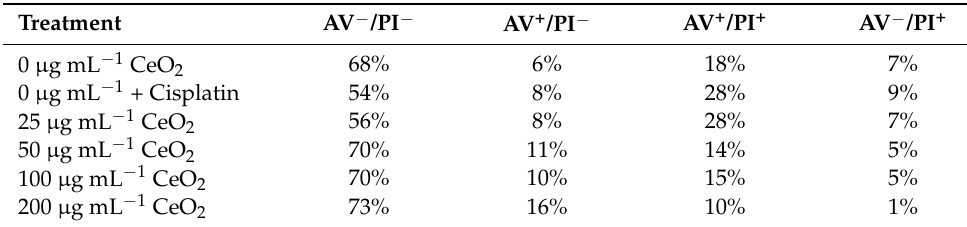
Table 3. Flow cytometry gated profiles of viable (AV − /PI − ), early apoptotic (AV + /PI − ), apoptotic and necrotic (AV + /PI + ), and already dead (AV − /PI + ) cells treated with varying concentrations of CeO 2 NP, or Cisplatin and irradiated with 1 Gy ionizing radiation.